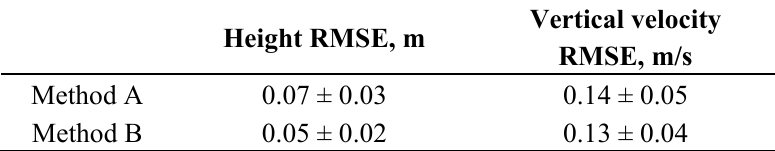
Table 3. RMSE statistics expressed as mean value ± standard deviation (SD) across N = 10